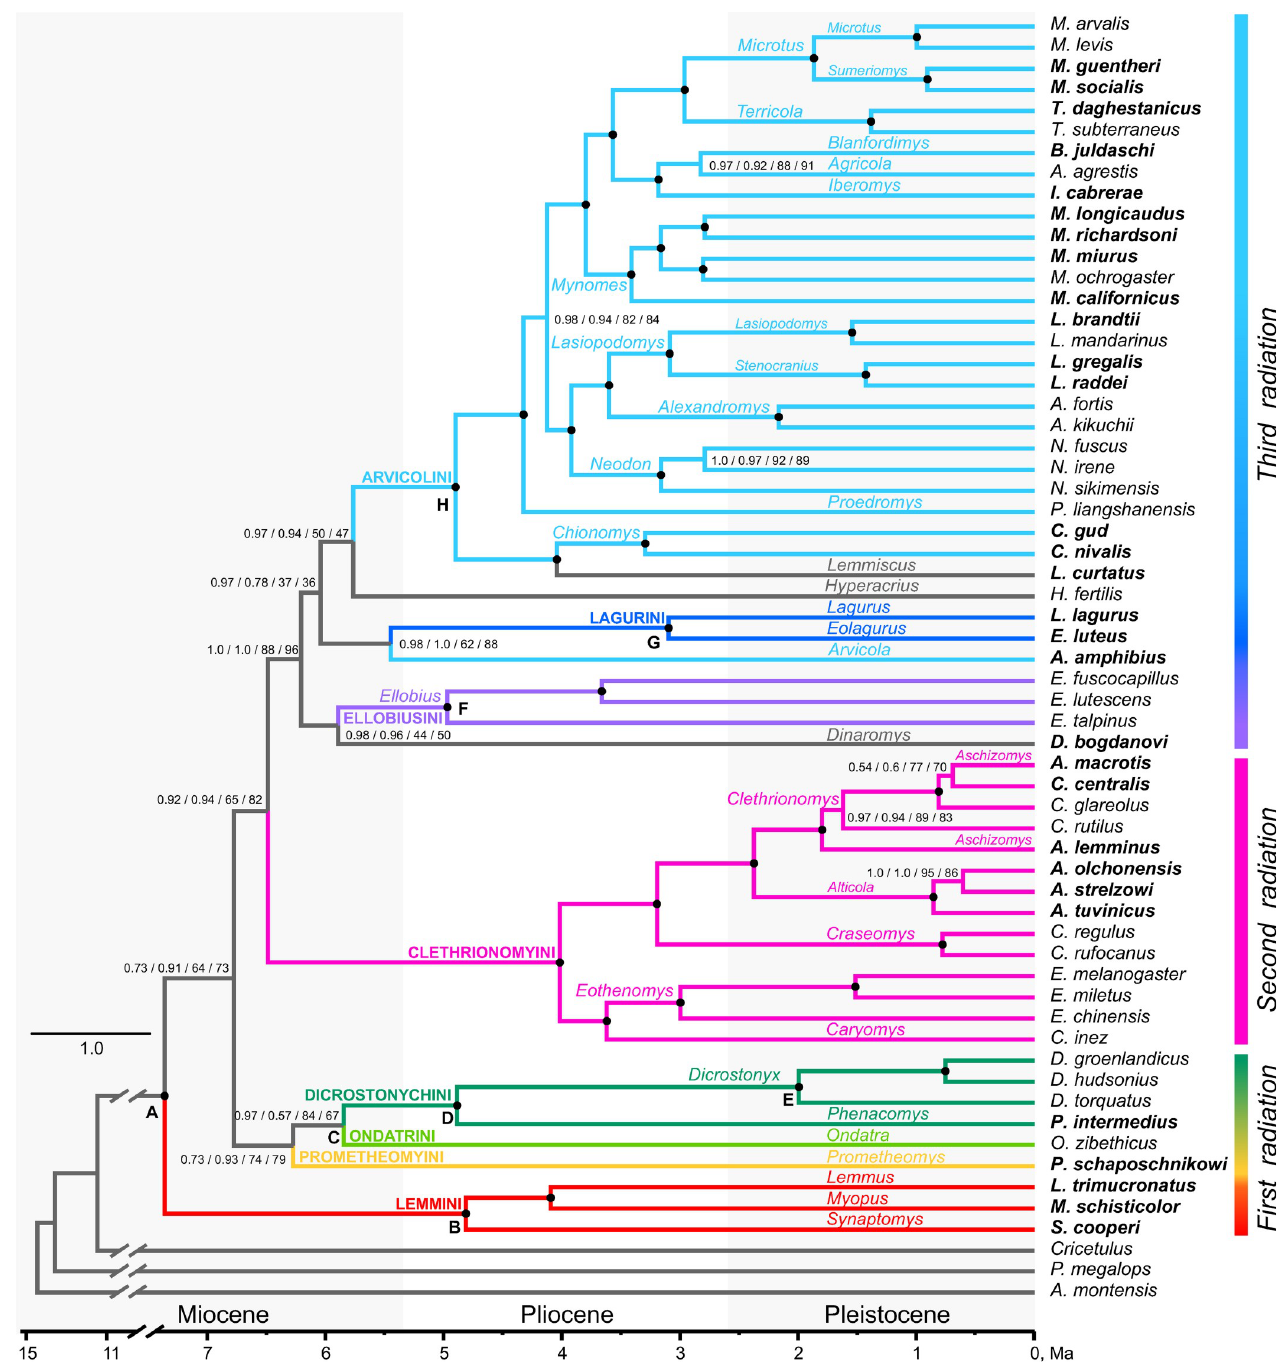
Fig 2. Time-calibrated mitochondrial phylogeny of Arvicolinae. Node labels display the following supports: BI complete / BI RY-coded 3rd codon position / ML complete / ML RY-coded 3rd codon position. Black circles show nodes with 0.95–1.0 BI and 95–100 ML support. All letters at nodes correspond to fossil constraints in S3 Table. Traditional tribal designations are also given above the branches and corresponding branches distinguished by different